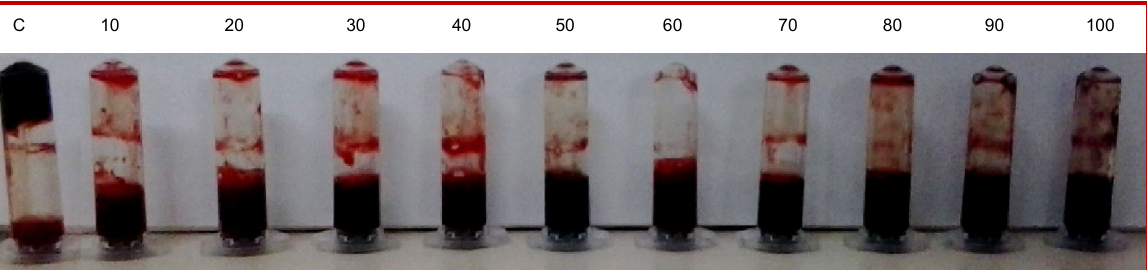
Figure 3: Holmstorm method for Bacillus sp SFN crude supernatant in production media without shrimp shell (10 to 100 µL)